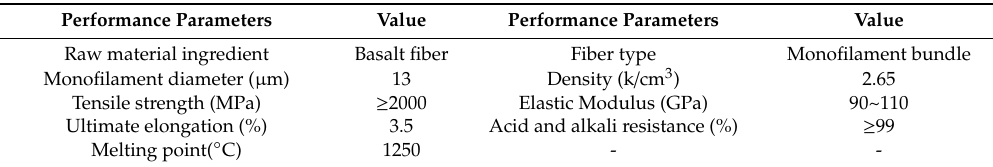
Figure 1. Alkali-resistant basalt fiber. Table 2. Performance parameters of alkali-resistant basalt fiber.